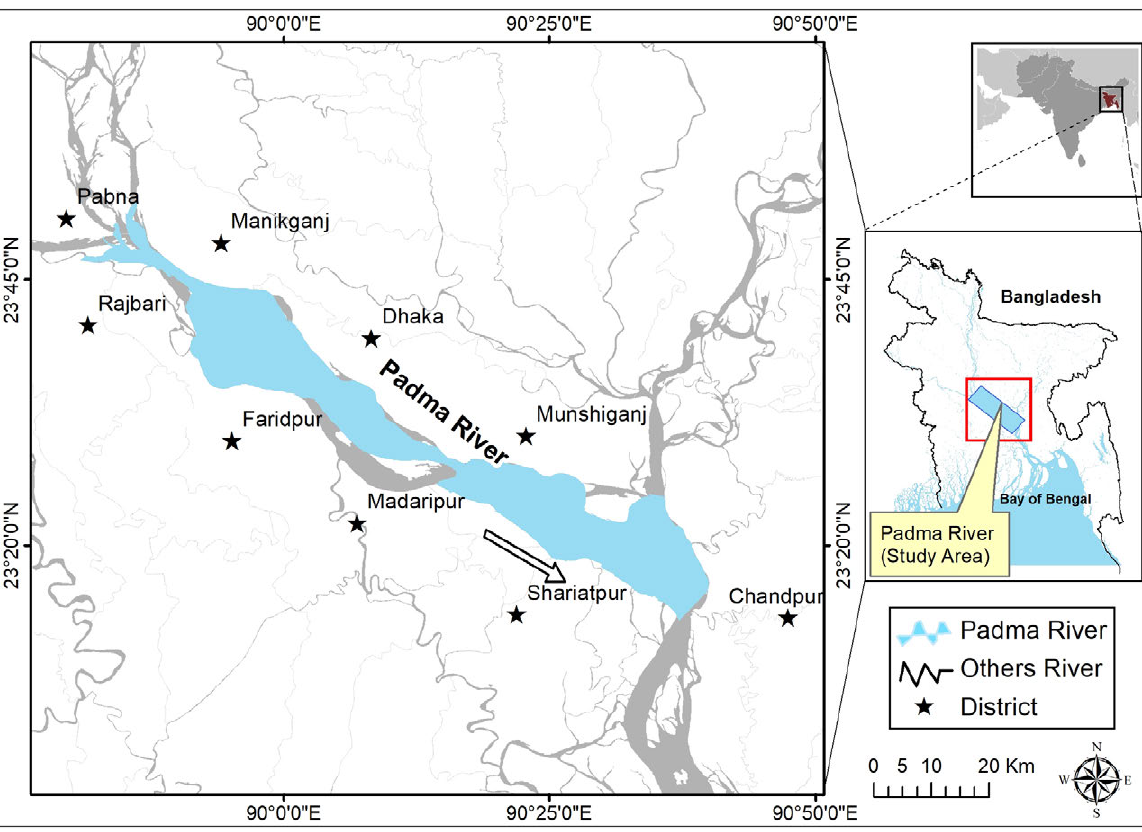
Fig. 1. Location of the study area.